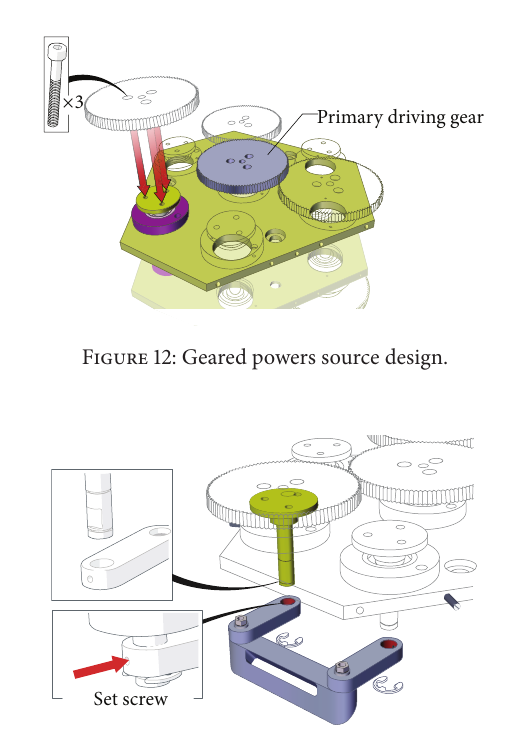
Figure 13: Transmission shaft